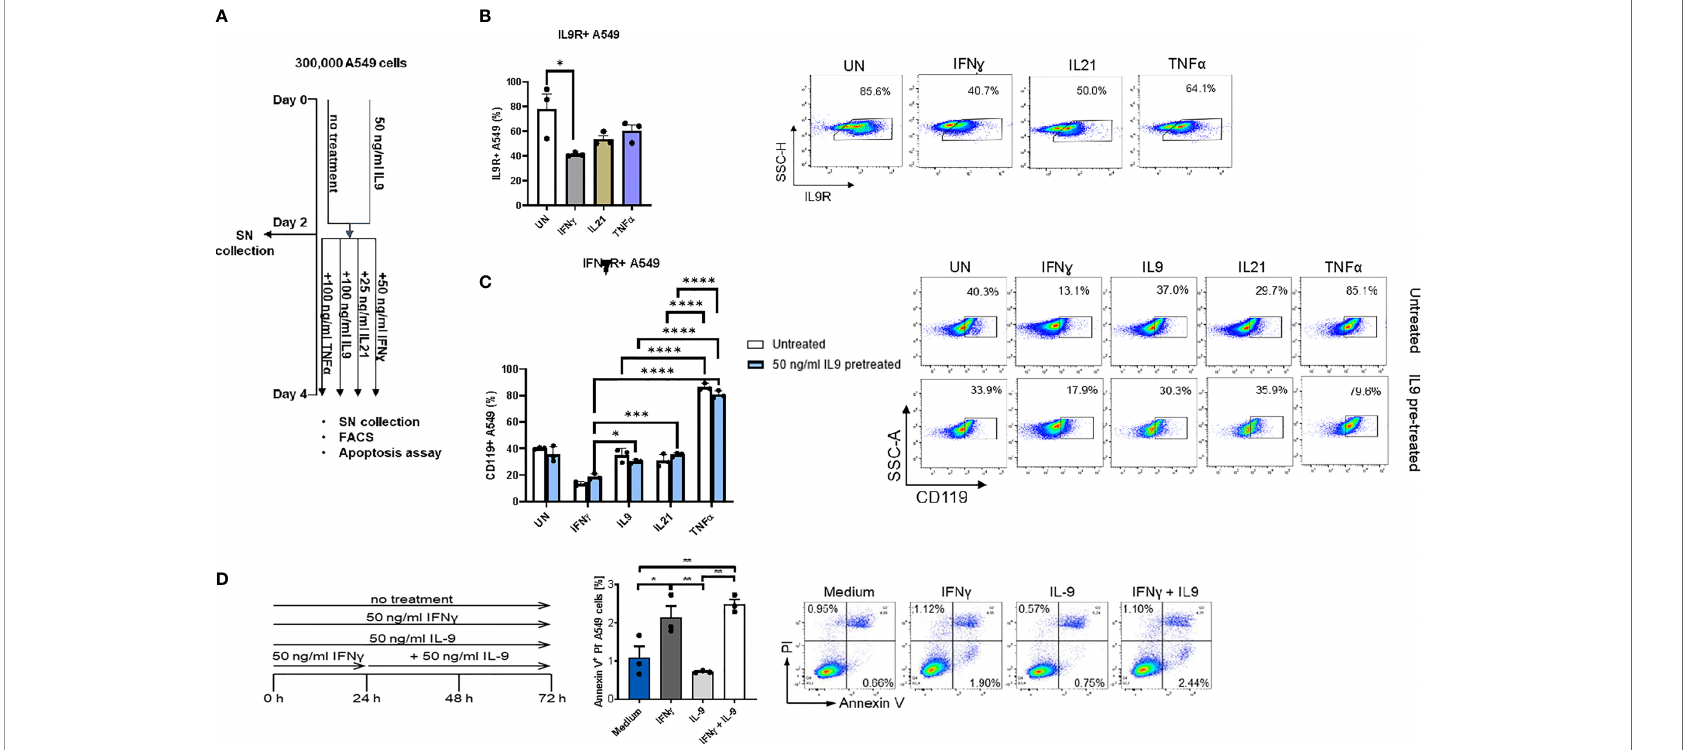
FIGURE 4 | Analysis of IL9 effects on cell surface receptors IL-9R and IFN g -R expression in vitro on A549 cell line. (A) Experimental design of A549 cell line culture for 4 days. A549 cells were pretreated with or without IL9 (50 ng/ml) for two days. On day 2, supernatants were collected and cells were further cultured for two days with IFN ɣ (50 ng/ml), IL9 (100 ng/ml), IL21 (25 ng/ml) or TNF a (100 ng/ml) in new medium, respectively. Cells were harvested for fl ow cytometry analysis and apoptosis assay on day 4. (B) Flow cytometry analysis of the percentage of IL9R expressing A549 cells unstimulated, or stimulated with IFN ɣ , IL21 or TNF a , respectively. A representative dot plot is shown for each group. (C) Flow cytometry analysis of the percentage of IFN ɣ R (CD119) expression A549 cells unstimulated or stimulated with IFN ɣ , IL9, IL21 or TNF a , respectively. Both IL9 pretreated and untreated A549 cells were analyzed. A representative dot plot is shown for each group. (D) Experimental design of A549 cell line culture for 72 hours. A549 cells were untreated, or treated with IFN ɣ (50 ng/ml) or IL9 (50 ng/ml) for 72 hours. In addition, one group was fi rst pretreated with IFN ɣ (50 ng/ml) for 24 hours, then stimulated with IL9 (50 ng/ml) for 48 hours. After 72 hours, all cells were harvested for fl ow cytometry analysis for cell apoptosis. Flow cytometry analysis of the percentage of A549 early apoptosis (Annexin V+PI- cells) in unstimulated cell culture condition or in condition of IFN ɣ , IL9, IFN ɣ +IL9, respectively. A representative dot plot is shown for each group. All data were statistically analyzed with ordinary one-way ANOVA or two-way ANOVA, and showed with mean ± SEM. n=3 per group. *P < 0.05; **P < 0.01; ***P < 0.001; ****P <